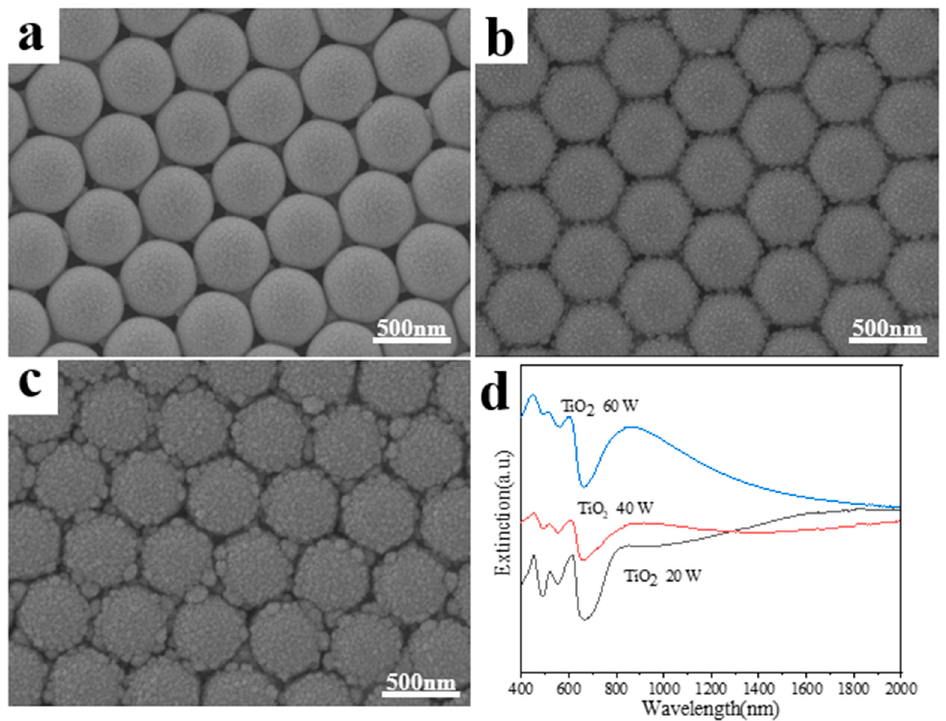
Figure 2. ( a – c ) SEM images for the samples with TiO 2 sputtering power 20 W, 40W and 60 W respectively and Ag sputtering power of remains unchanged; ( d ) Extinction spectra for the above three structures.